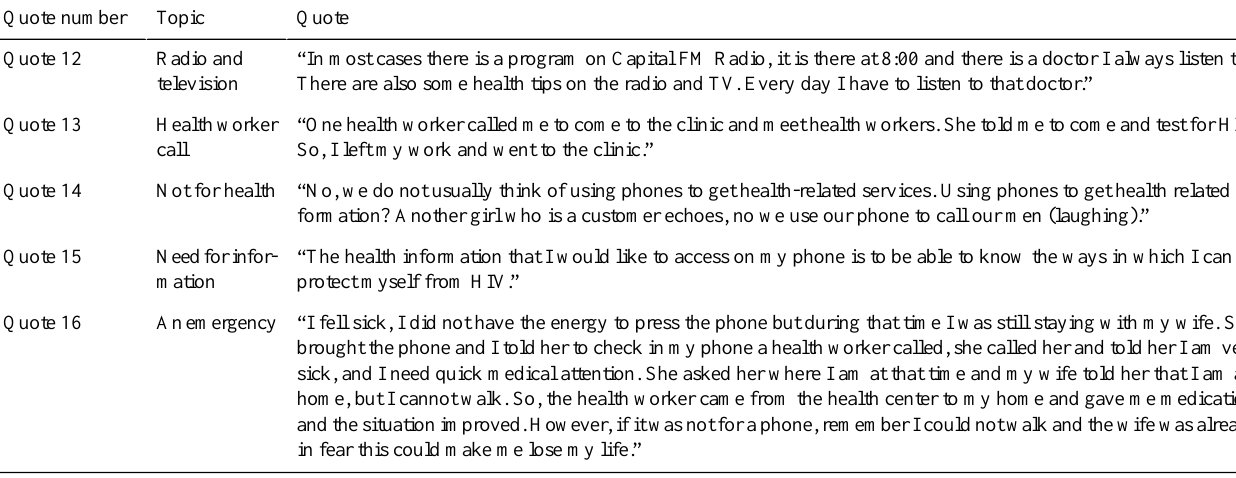
Table 5. Mobile phones and health information. QuoteTopicQuote